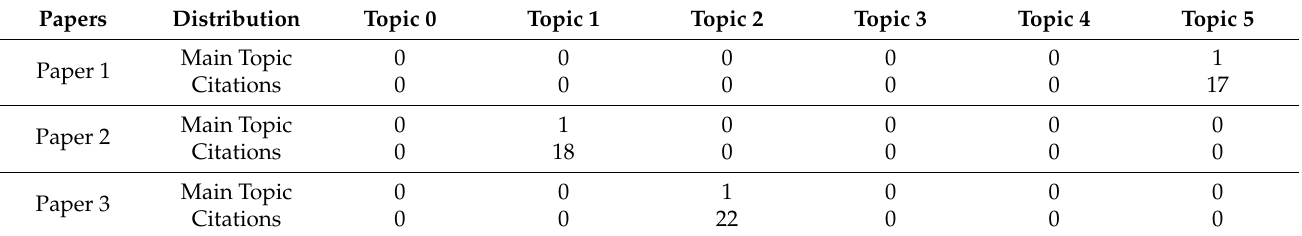
Table 11. Distribution of topics and citations in vector format.